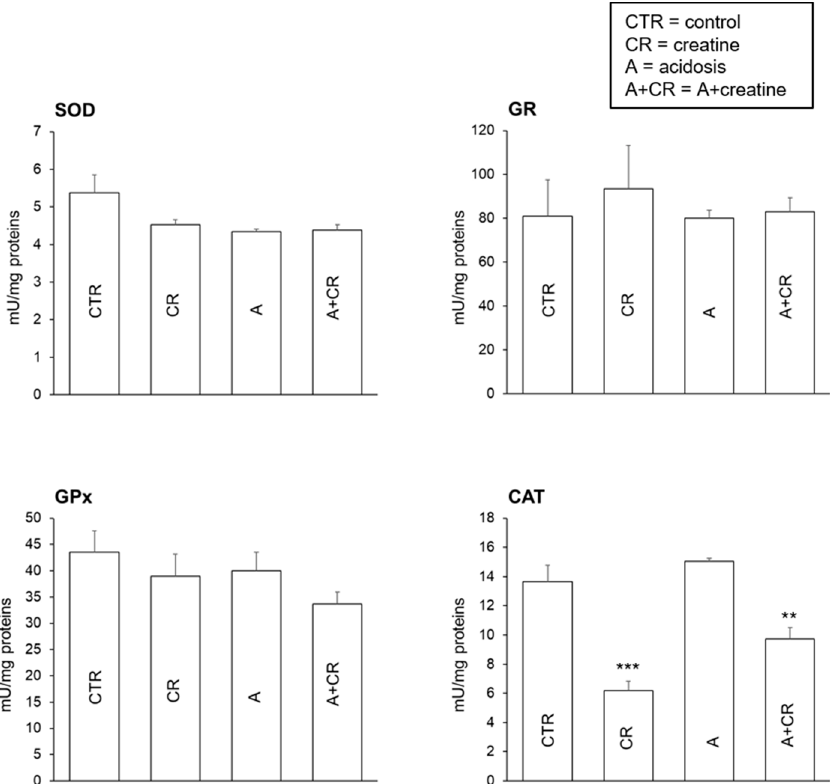
Figure 3. E ff ects of 11 d administration of 20 mM creatine on superoxide dismutase (SOD), glutathione peroxidase (GPx), glutathione reductase (GR), and catalase (CAT) activity in jejunal mucosal homogenate under control conditions and chronic acidosis. Values are means ± S.E. Number of experiments = 4 with duplicate estimation. *** p ≤ 0.001 vs. control and acidosis. ** p ≤ 0.05 vs. control and acidosis.